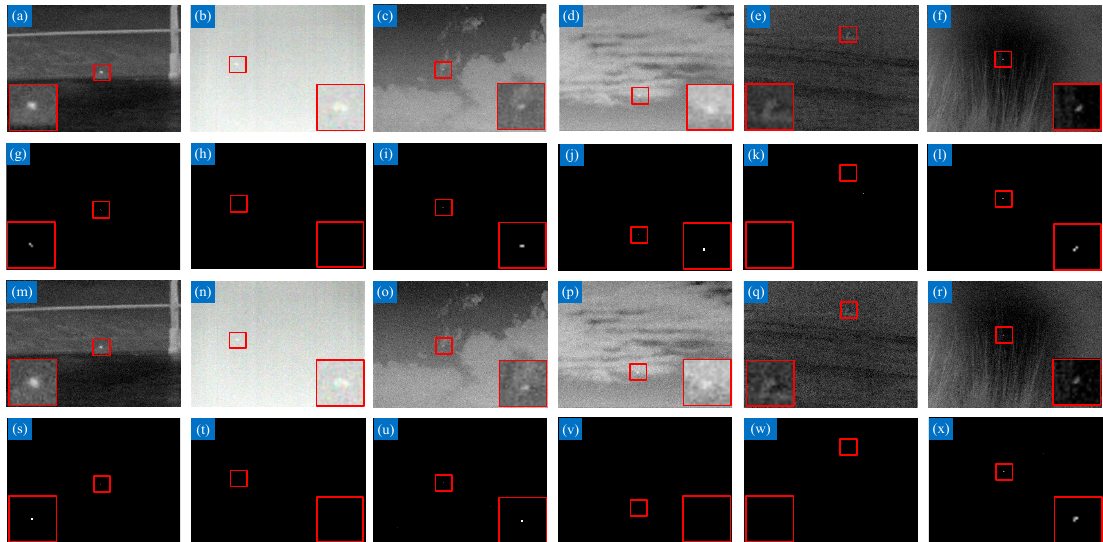
Figure 13. The first and third row are infrared images with additive white Gaussian noise with standard deviations of 10 and 20, and the second and fourth rows are the corresponding detection results by the proposed method.